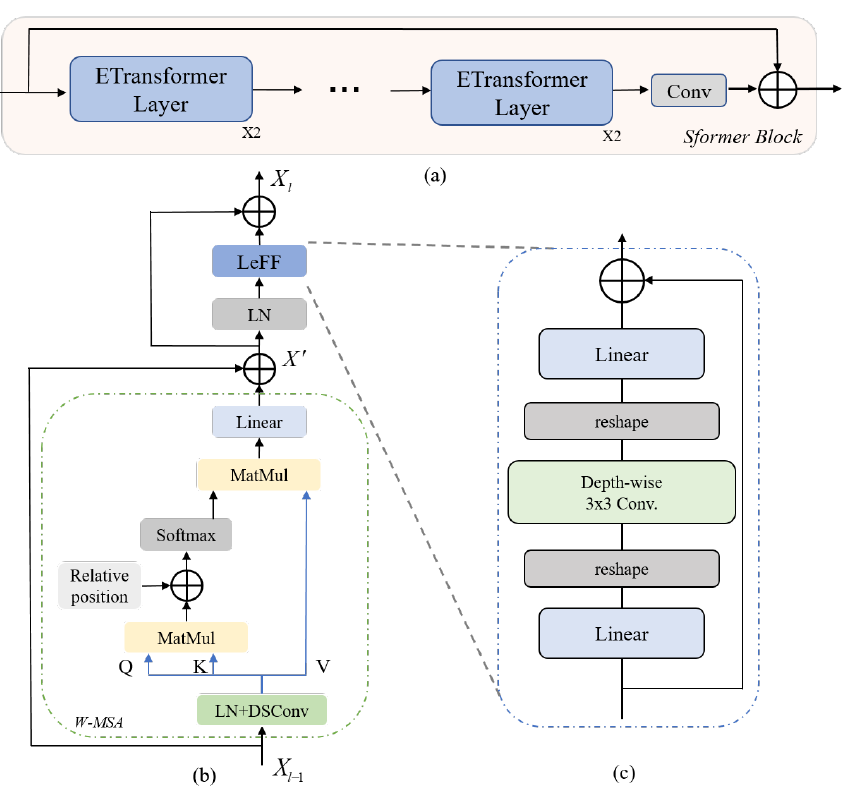
Figure 2. ( a ) Sformer block. ( b ) Architecture of the ETransformer. ( c ) Structure of the